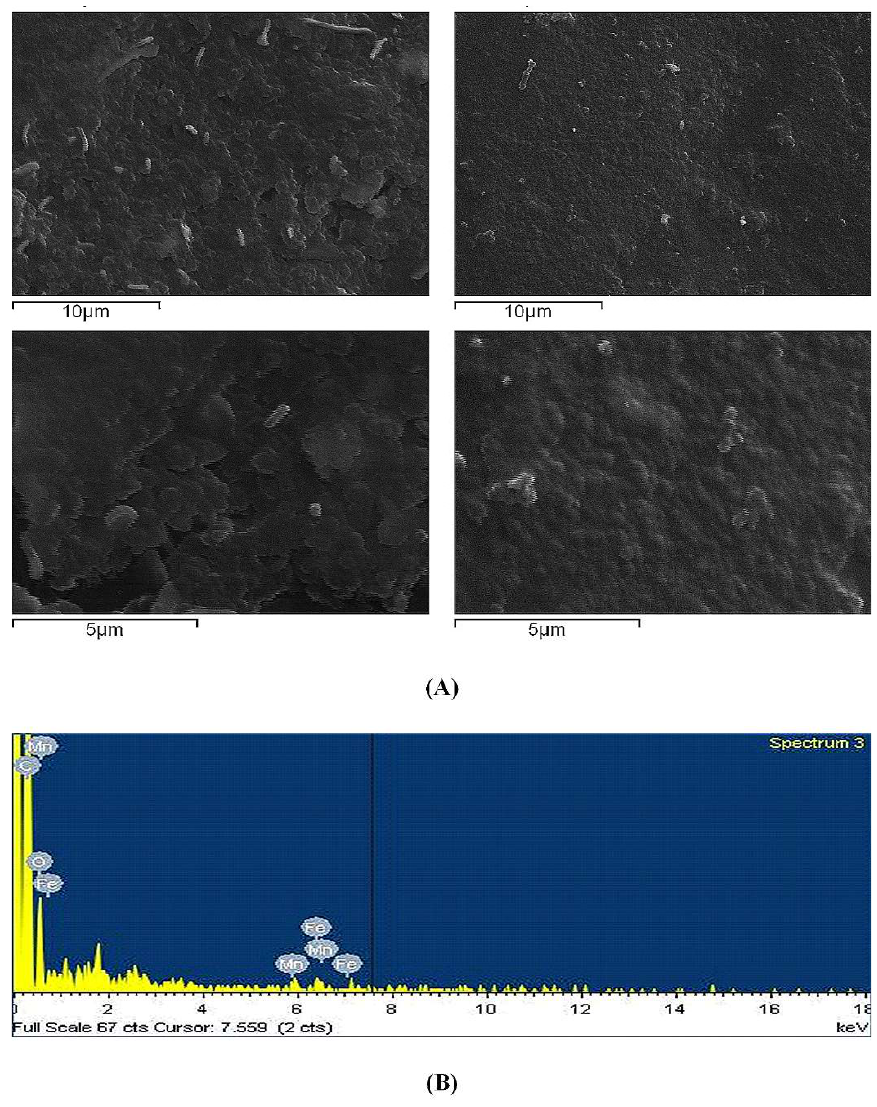
Figure Figure A3. SEM and EDS analysis of the prepared magnetic core–shell drug-loaded polymeric nanoparticles.